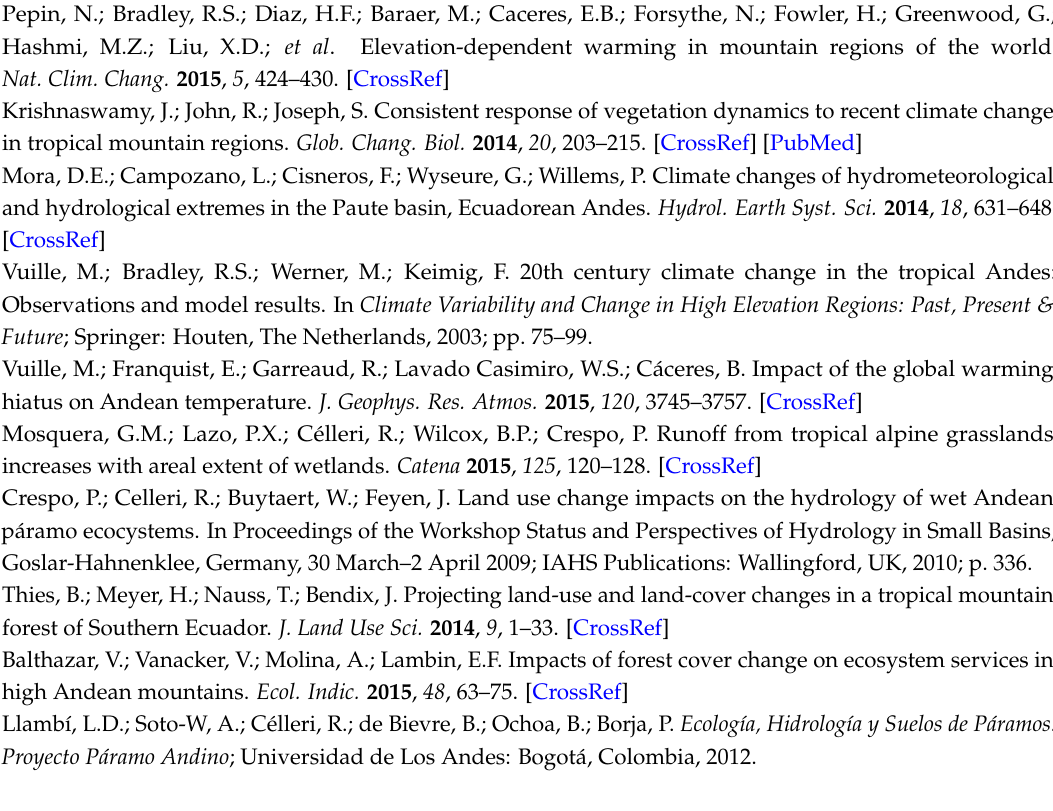
Figure S1: METRIC L and METRIC M algorithms flowchart (adapted from equations of Allen et al. [1] and Trezza et al. [2])., Table S1: Abbreviations used in this supplementary information (Equations (S1)–(S32)), and a detailed description of the METRIC Landsat-Based